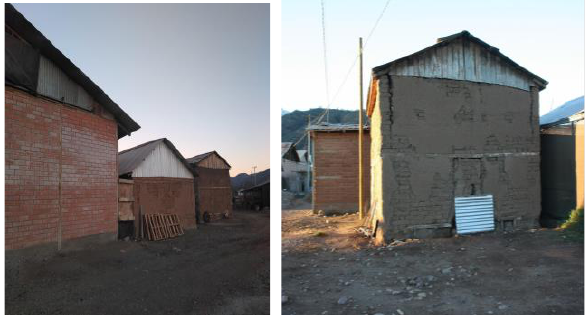
Figure 7. Lowered furnaces in Chuchiñi.